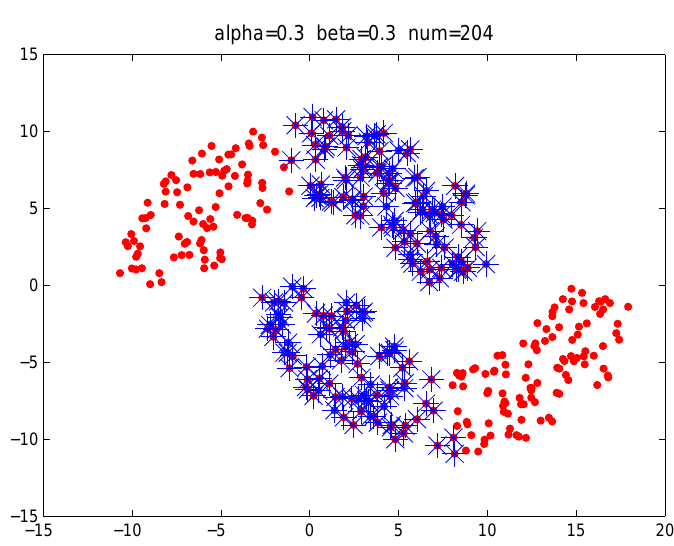
Figure 16. The “bad data points” found under α = 0.3, β = 0.3, and m = 5.